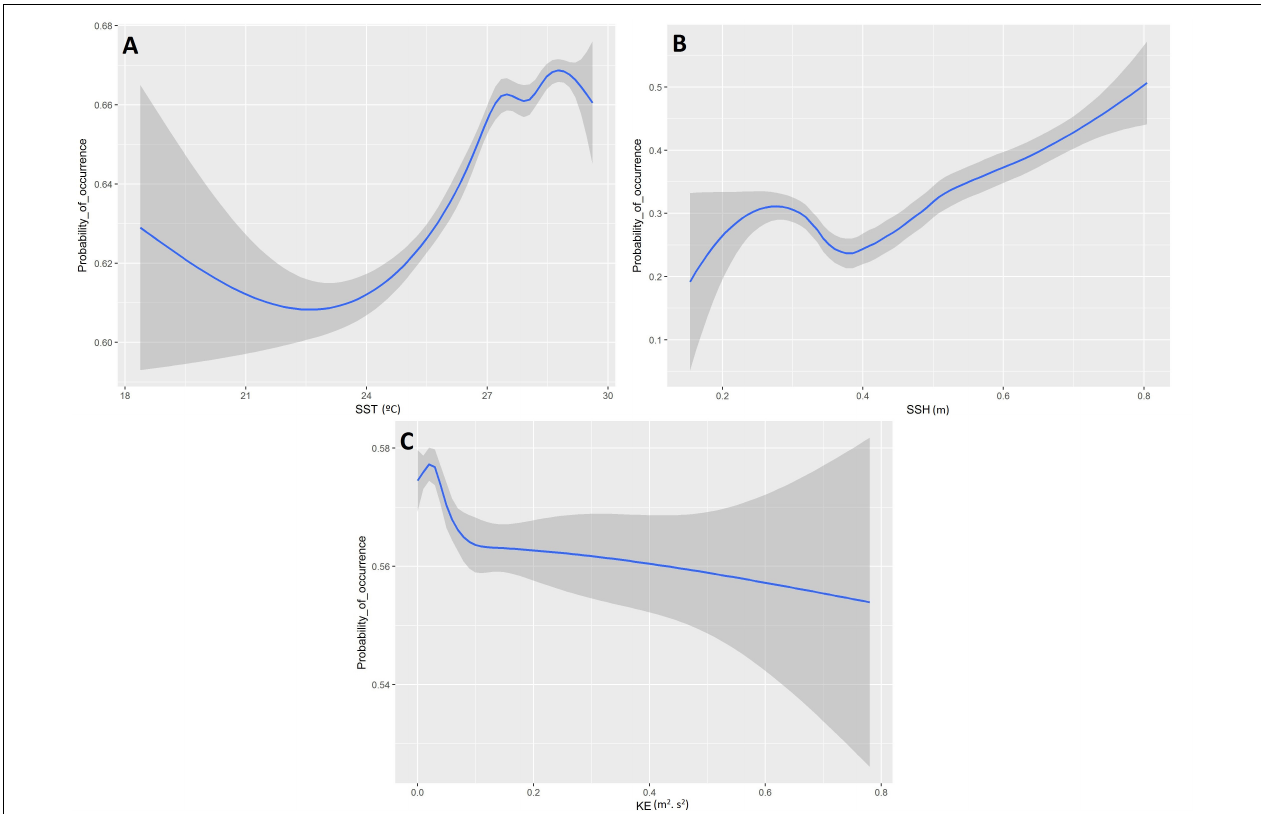
FIGURE 2 | Functional responses of the final tuna B-HSMs ( A , Sea Surface Temperature; B , Sea Surface Height; C , Kinetic Energy). The solid line represents the smooth function estimate; the shaded region represents the approximate 95% credibility